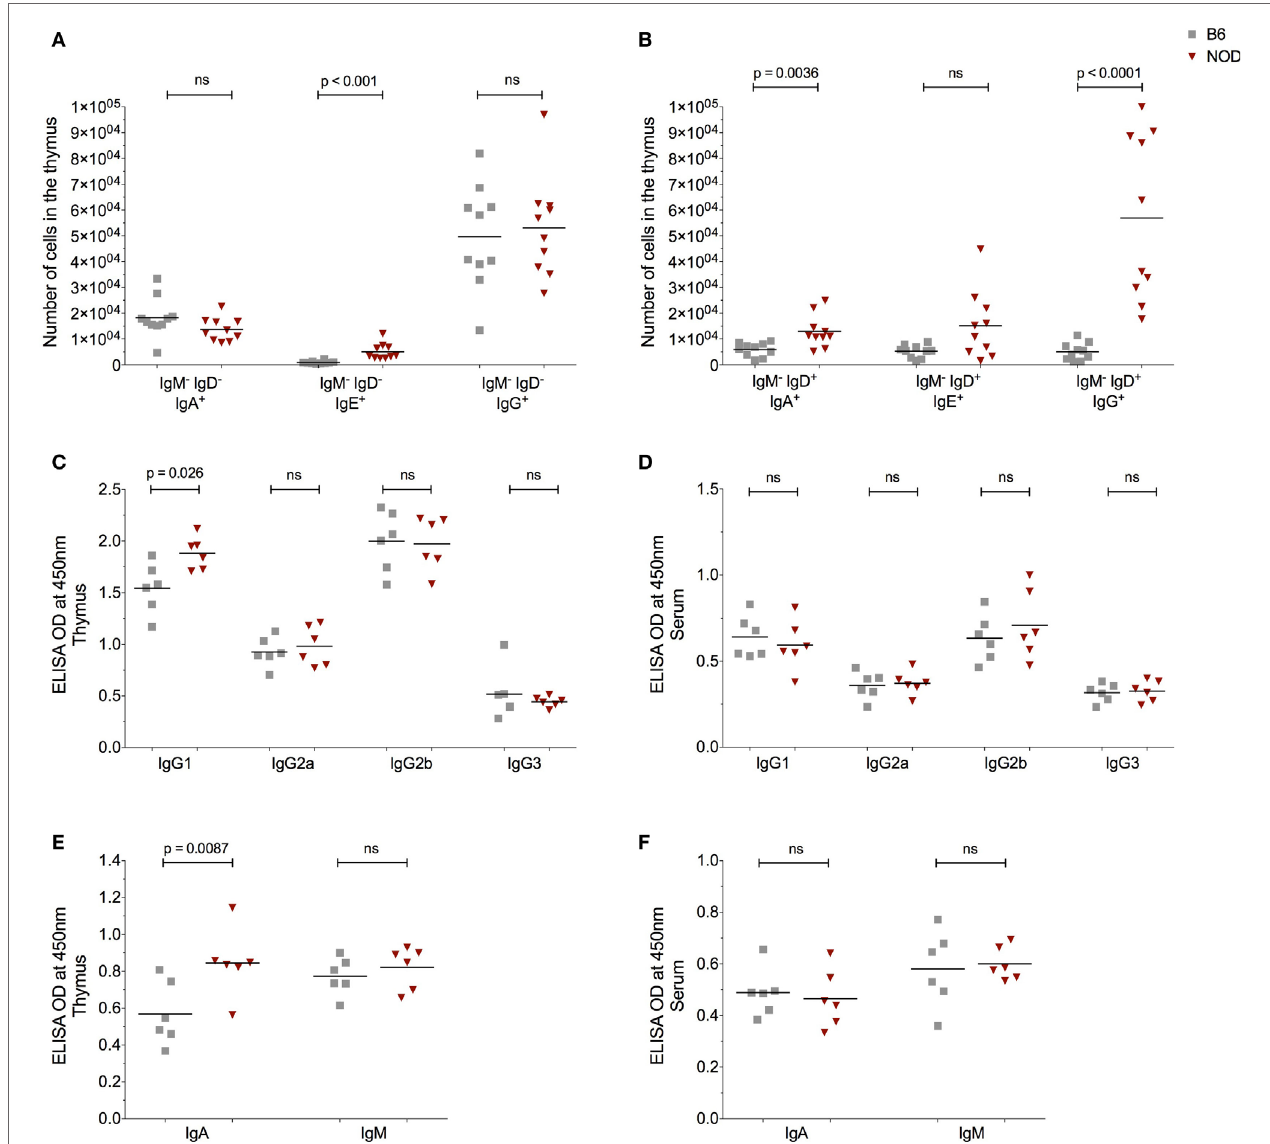
FigUre 4 | The non-obese diabetic (NOD) thymus harbors a unique pattern of immunoglobulin (Ig) isotypes. (a) Number of IgM − IgD − IgA + , IgM − IgD − IgE + , and IgM − IgD − IgG + B cells in the thymus of 11- to 14-week-old female B6 ( n = 10) or female NOD mice ( n = 10). (B) Number of IgM − IgD + IgA + , IgM − IgD + IgE + , and IgM − IgD + IgG + B cells in the thymus of 11- to 14-week-old female B6 ( n = 10) and female NOD mice ( n = 10). (c–F) Optical density (OD) values of the respective Igs in cell-free tissue supernatants (c,e) or serum (D,F) . A total of six female B6 and six female NOD mice were assessed in two independent experiments. Data are presented as scatter plot, each dot equating to one mouse and bar representing the mean. P values were calculated using the Mann–Whitney U -test analysis and are shown in this figure; ns, not